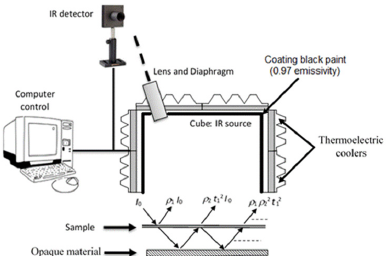
Figure 2. Experimental setup with measurement configuration. IR: infrared.